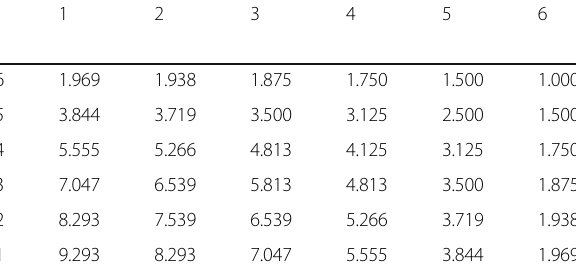
Table 4 The data packet forwarded of node in Grid network